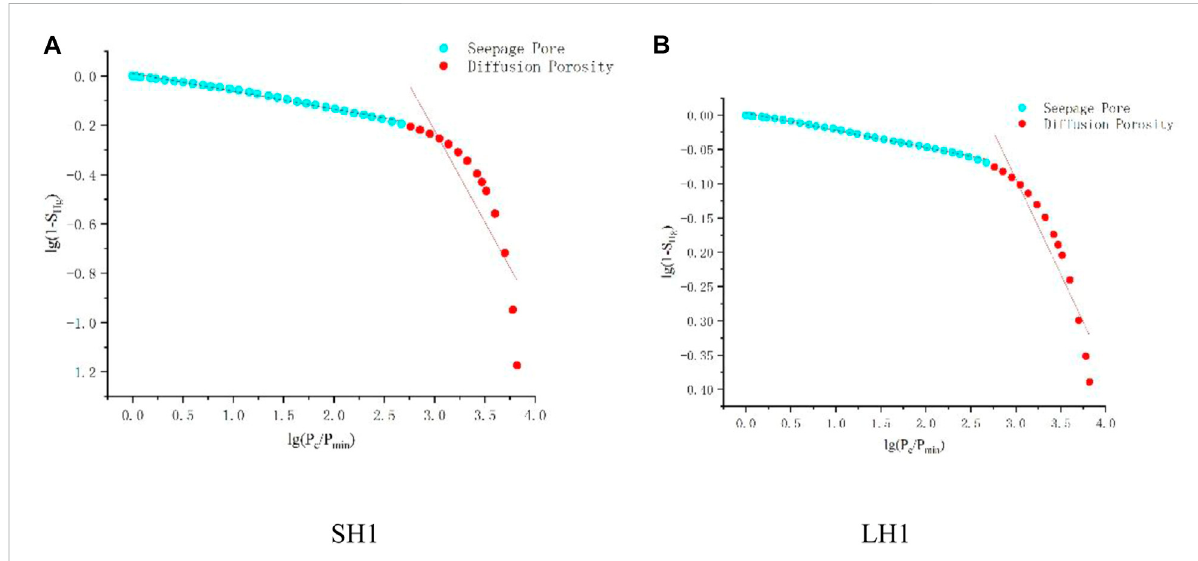
FIGURE 6 Characteristics of the fractal double logarithm curve of the coal sample. (A) SH1; (B)